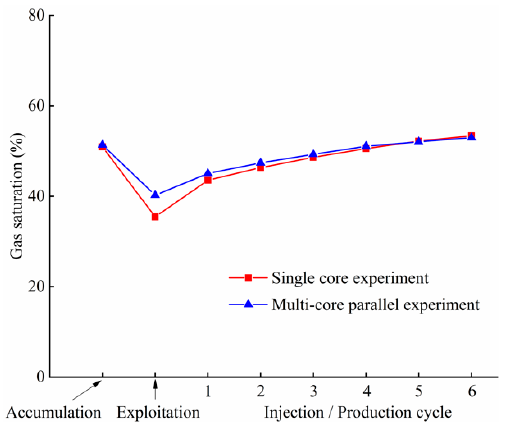
Figure 9. Variation curve of gas saturation with reservoir heterogeneous in the gas-drive-water gas zone.